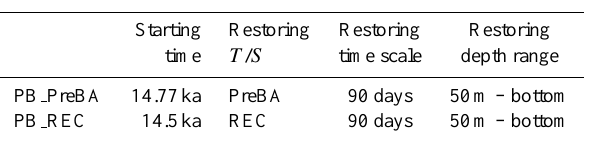
Table 1. Configuration of sensitivity